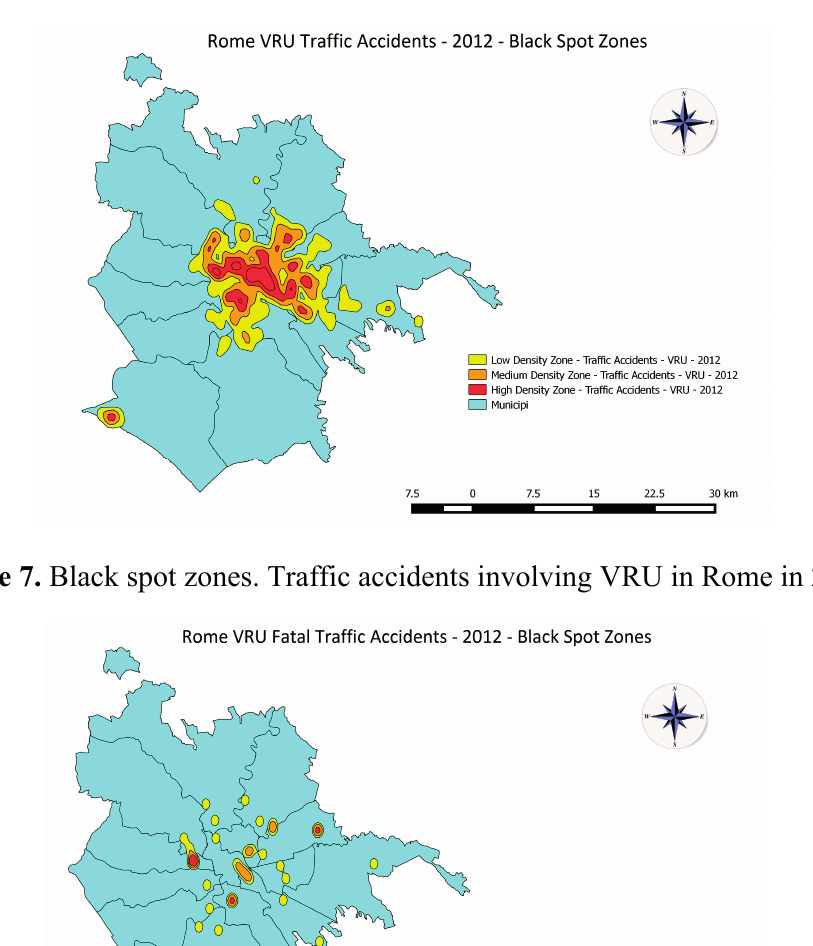
Figure 6. Black spot zones. Fatal traffic accidents involving VRU in São Paulo in 2012.